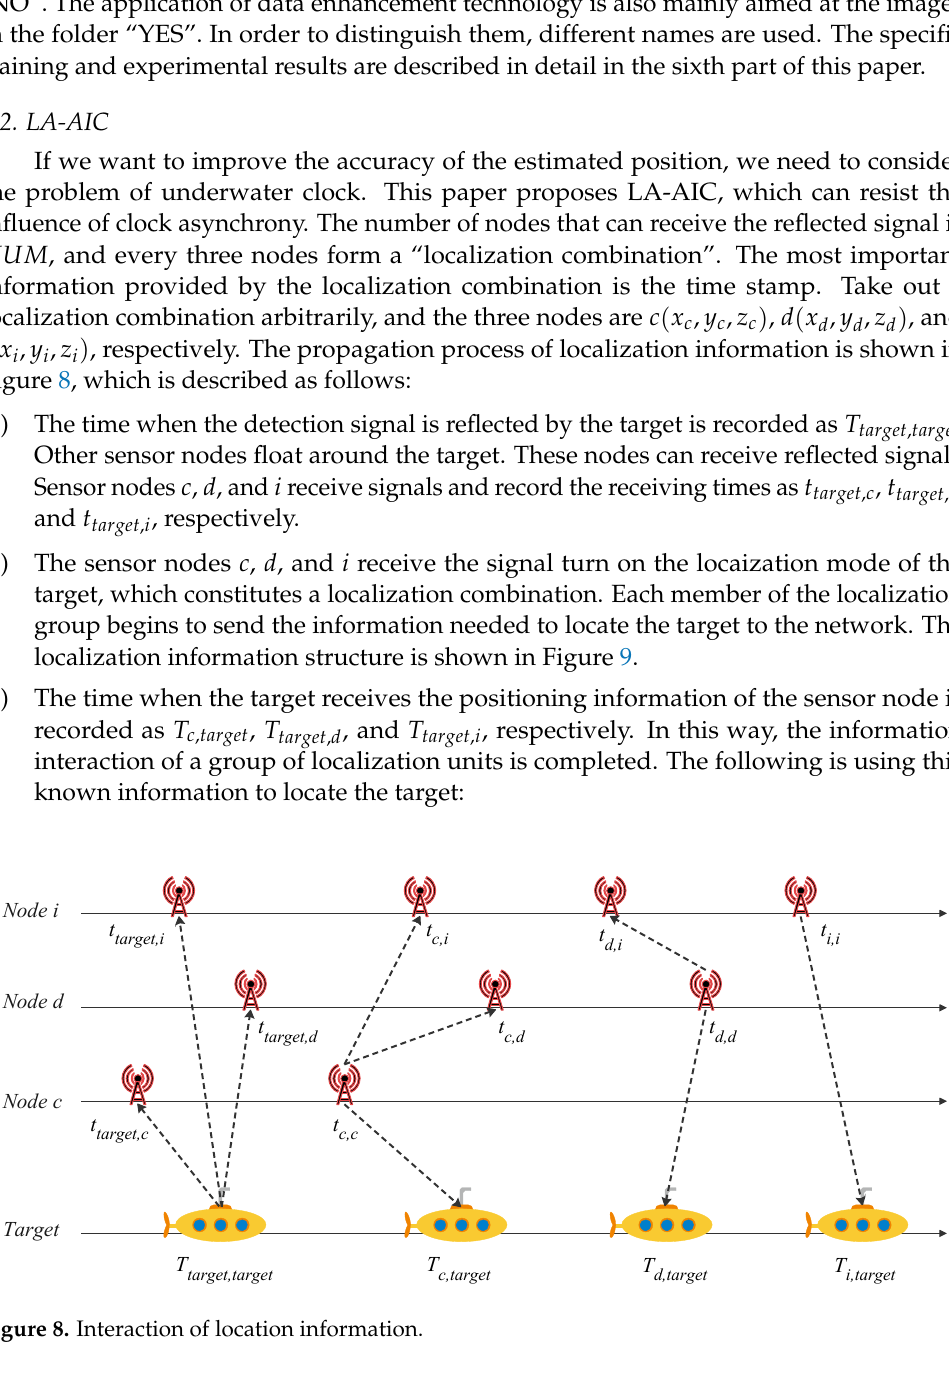
Figure 7. Training images. (a) Positive image. (b) Negative image. (c) Negative image.